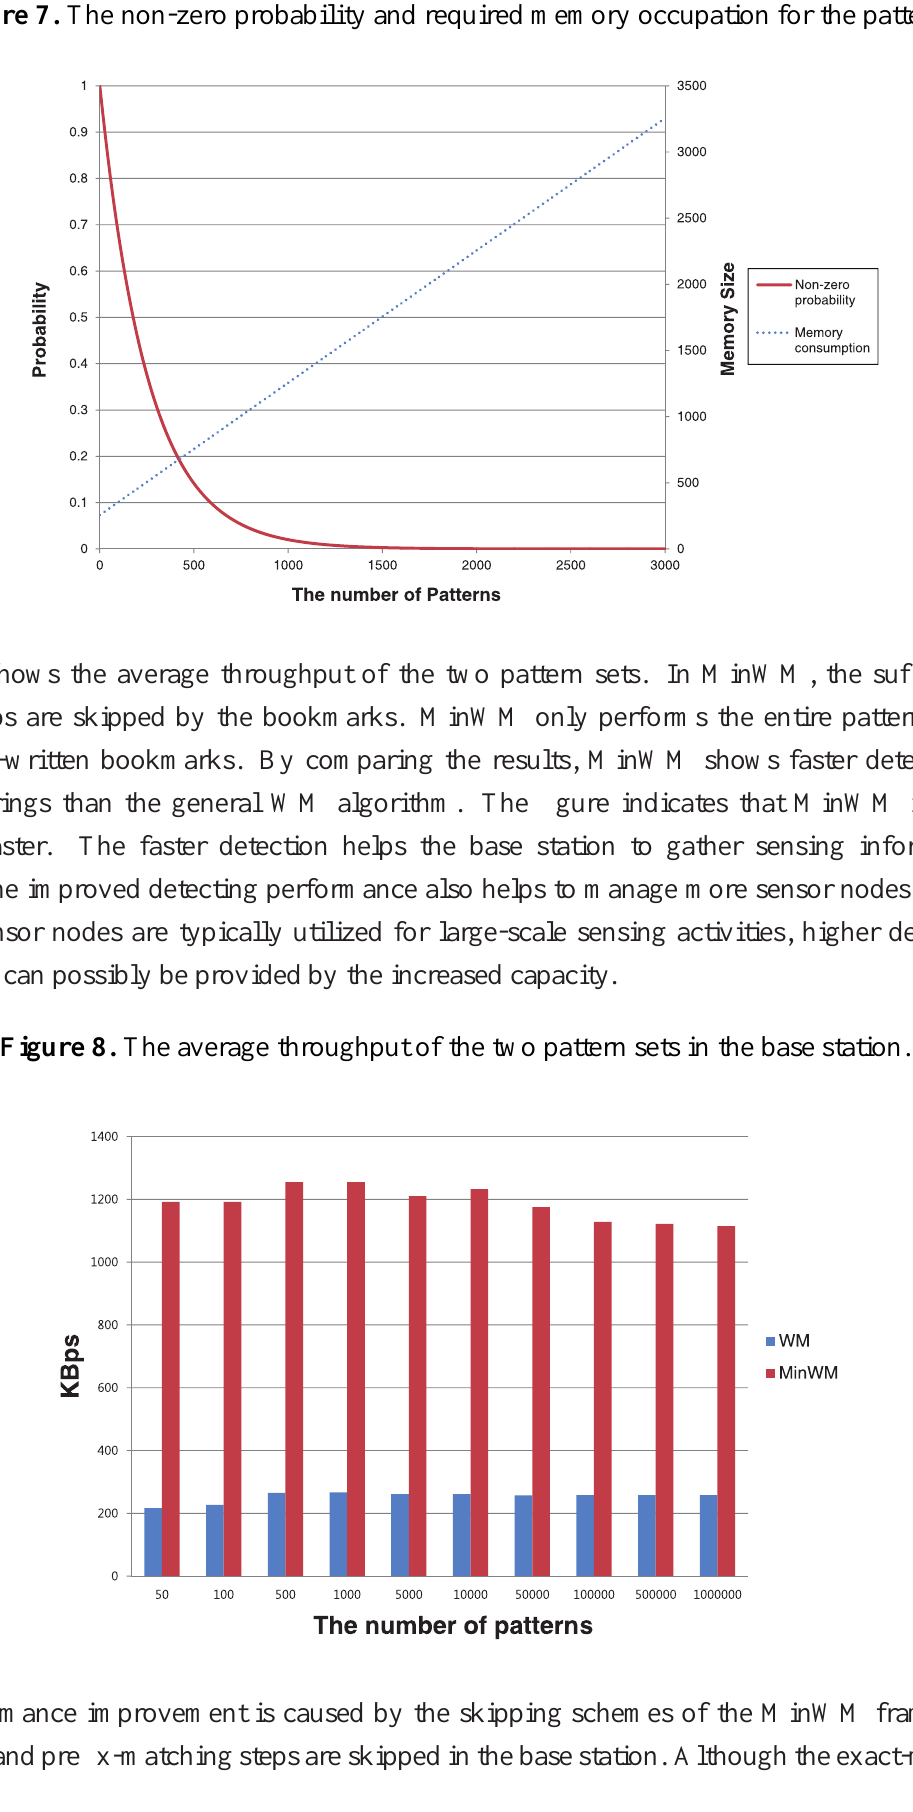
Figure 7. The non-zero probability and required memory occupation for the patterns.